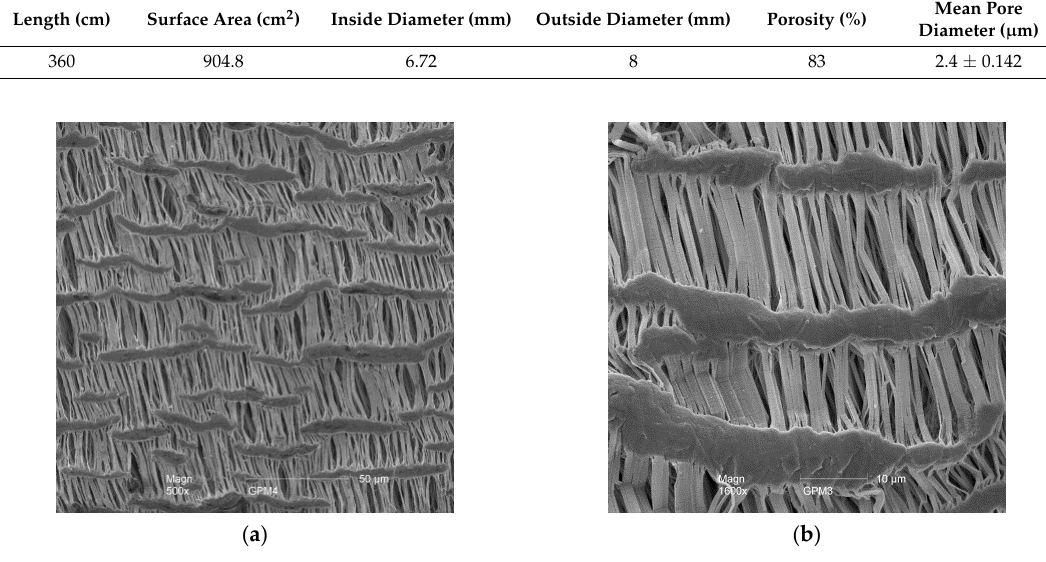
Figure 5. Microscopic photographs of the ePTFE membrane at 500× magnification ( a ) and 1600× magnification ( b ).